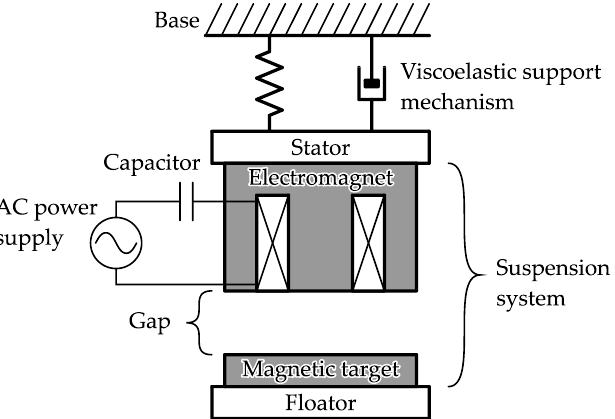
Figure 1. Schematic view of AC magnetic suspension system. The mechanical part in the system consists of an electromagnet fixed to the ground through a viscoelastic support mechanism and a floator with a magnetic target. The electromagnet is connected in series with a capacitor and an AC signal generator, electrically.